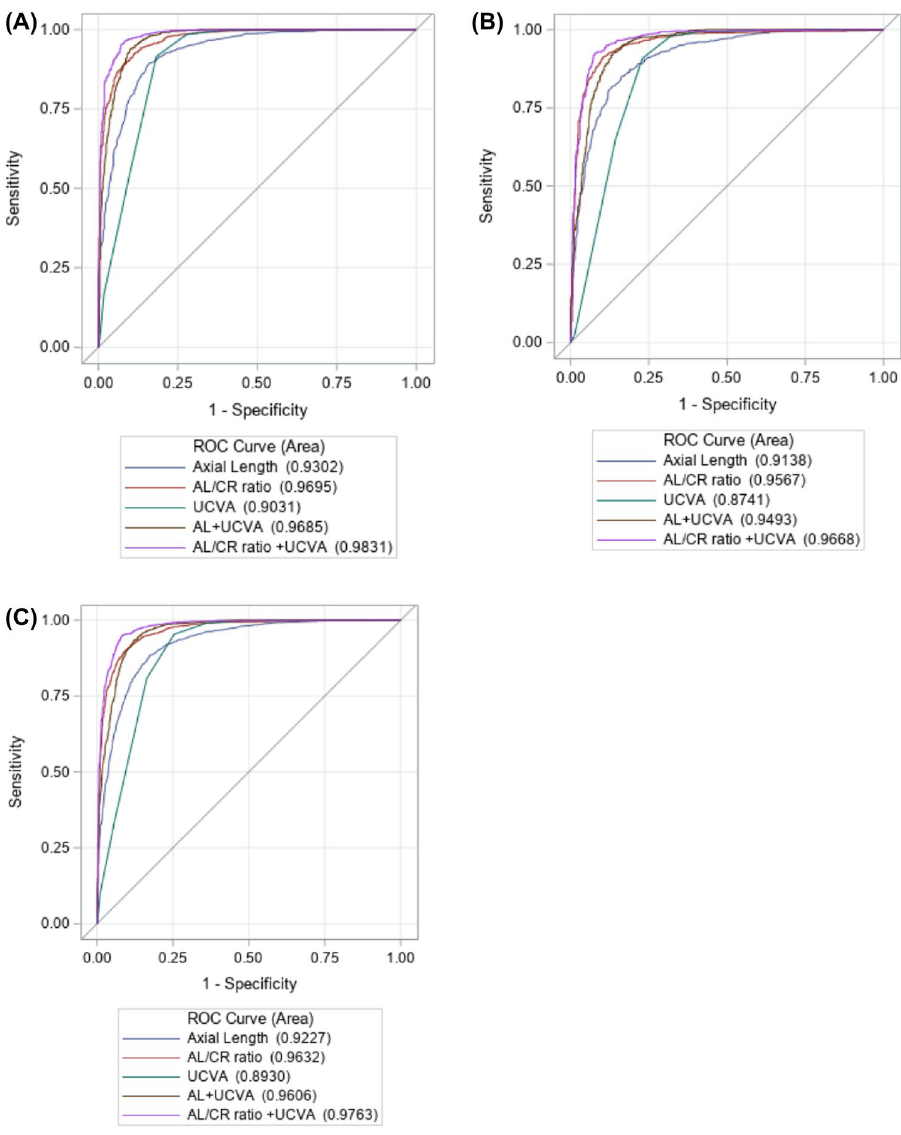
Figure 3. ROC curves using various measures for predicting myopia in development data ( A ), validation data ( B ) and combined data ( C ) using ocular biometric measures, UCVA and their